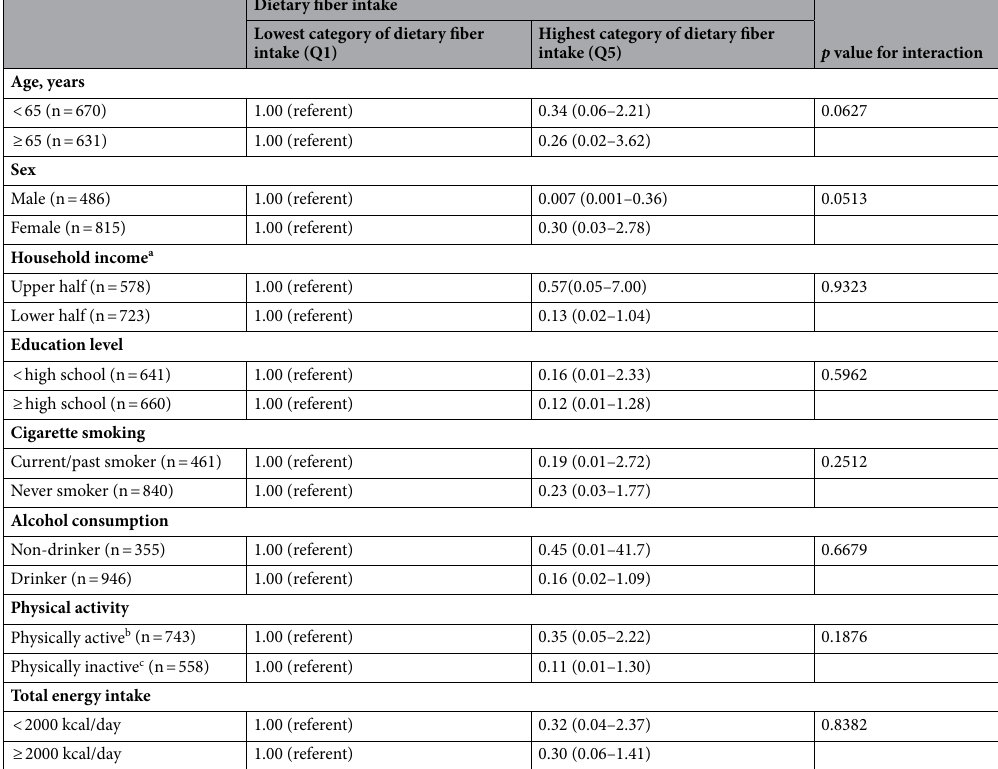
Table 3. Subgroup analysis for association of dietary fiber intake and metabolic syndrome in adult cancer survivors in the Korea National Health and Nutrition Examination Survey VI and VII (2013–2018). OR (95% CI) above are presented as odds ratio and 95% confidence intervals from multiple logistic regression adjusted for age, sex, household income, education level, cigarette smoking, alcohol consumption, physical activity, and total energy intake (except for the variable in the subgroup category) and all values presented above are weighted according to the national adult population of the KNHANES (2013–2018). a Proxy for socioeconomic status (calculated from the sum of the income from the members of each household divided by the square root of the number of household members). b Reported to engage in at least one of the following activities: